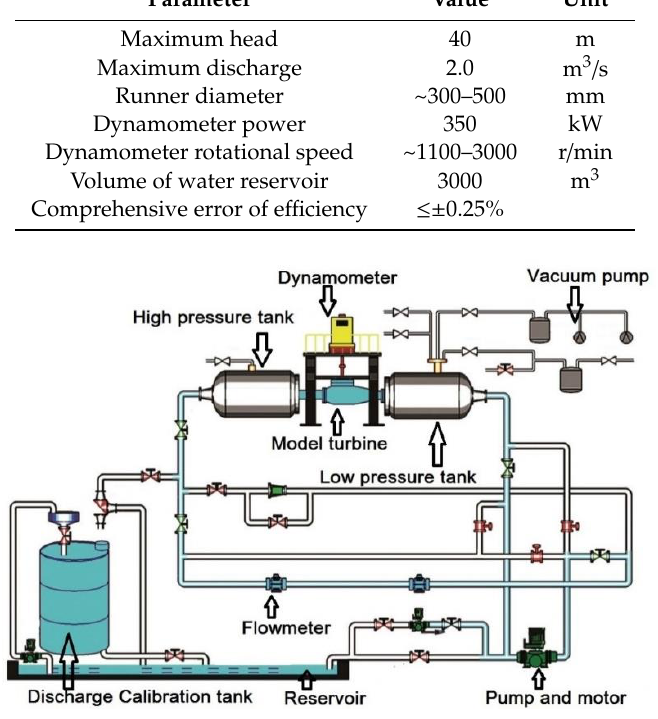
Figure 4. Sketch of the test rig.